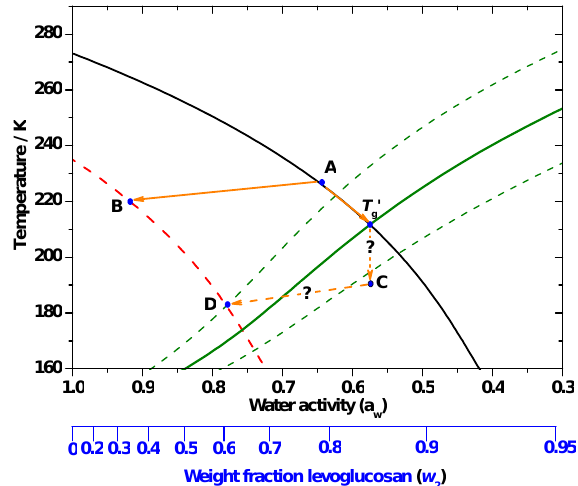
Fig. 3. The phase diagram of levoglucosan solution aerosol. The black line is the ice liquid equilibrium line, the dashed red line is the homogeneous freezing threshold based on the water activity ho- mogeneous freezing criteria (Koop et al., 2000) and the green solid line is the humidity induced glass transition threshold (RH g ) for levoglucosan solution aerosol, with associated upper and lower un- certainties (dashed green lines) based on uncertainties in the pa- rameters used in the Gordon-Taylor equation (Eq. 1) (Zobrist et al., 2008). The orange arrows represent idealised temperature/humidity trajectories. The ice-liquid equilibrium and homogeneous freezing lines are common to all solutions used in this study, but RH g is unique to each solution